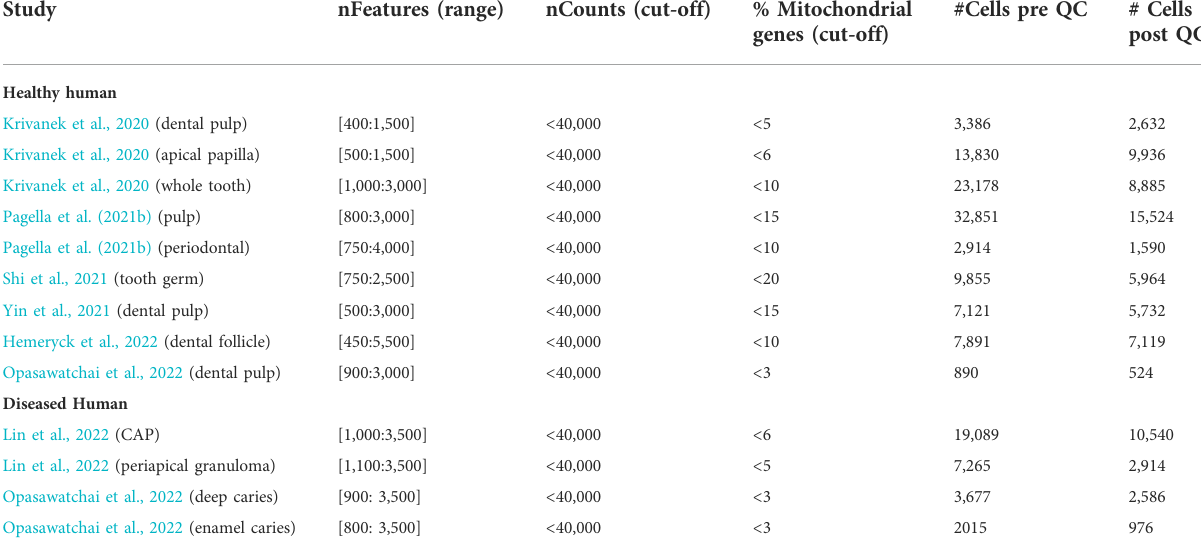
TABLE 5 Parameters used for quality control of the healthy human tooth scRNA-seq